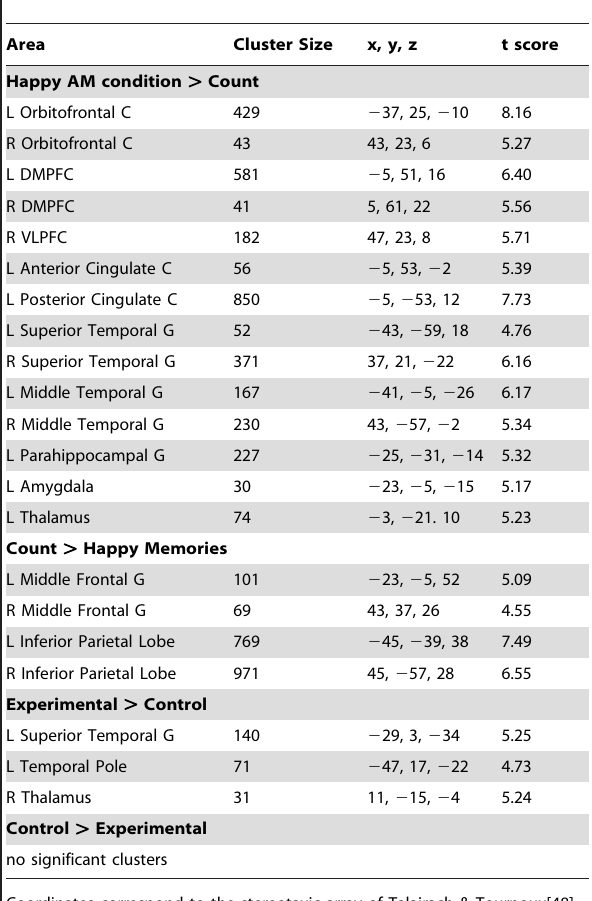
Table 4. Regional increases in BOLD activity during the Transfer